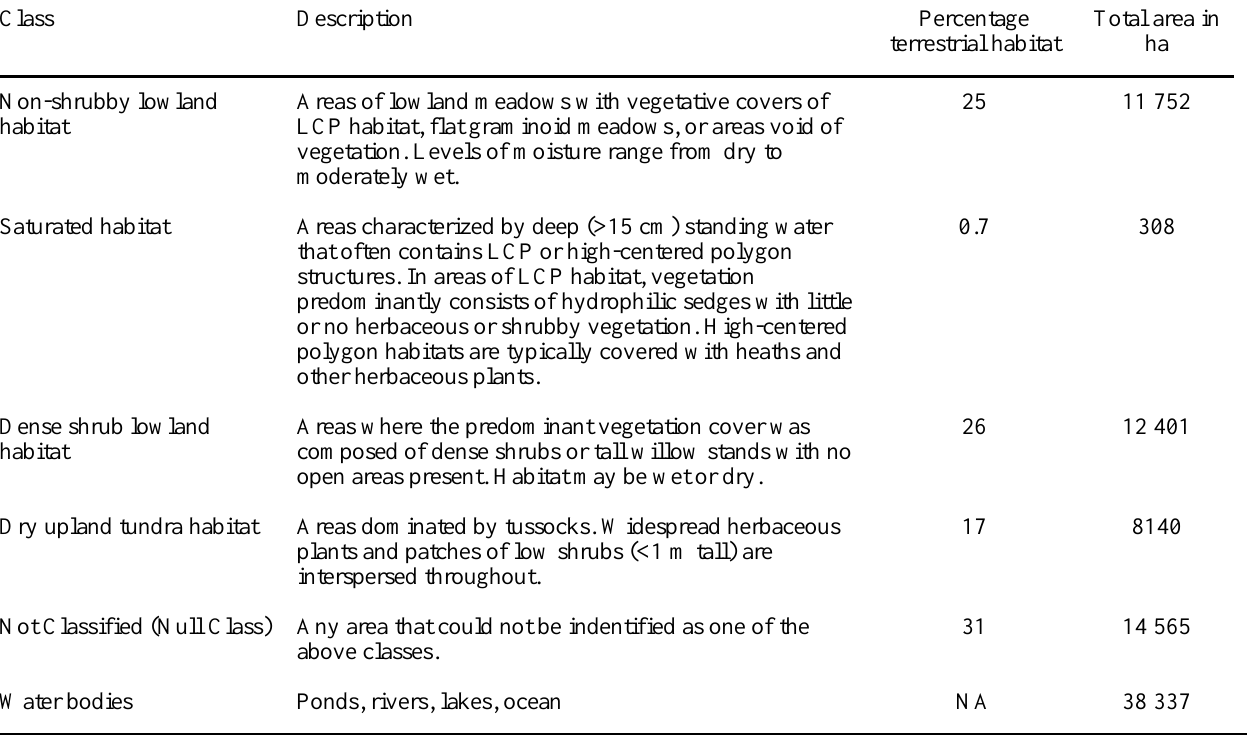
Table 2. Description of each land-cover class, the percentage of terrestrial habitat it encompasses, and the area estimates of land-cover classes from the supervised classification of the Kendall Island Bird Sanctuary and Fish Island in the outer Mackenzie Delta, Northwest Territories. Class Description Percentage Non-shrubby lowland habitat